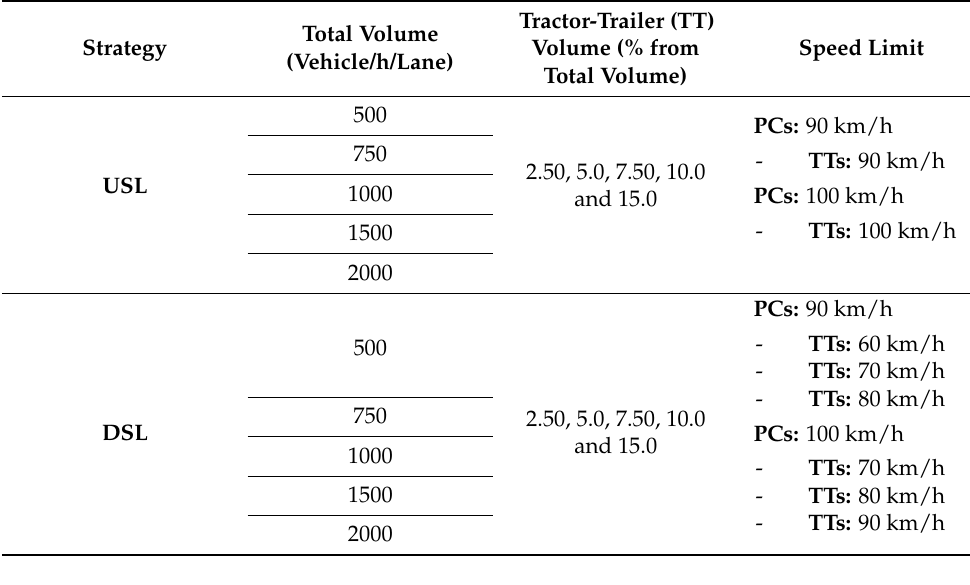
Table 2. Different combinations of traffic volumes, %TTs and speed limit.